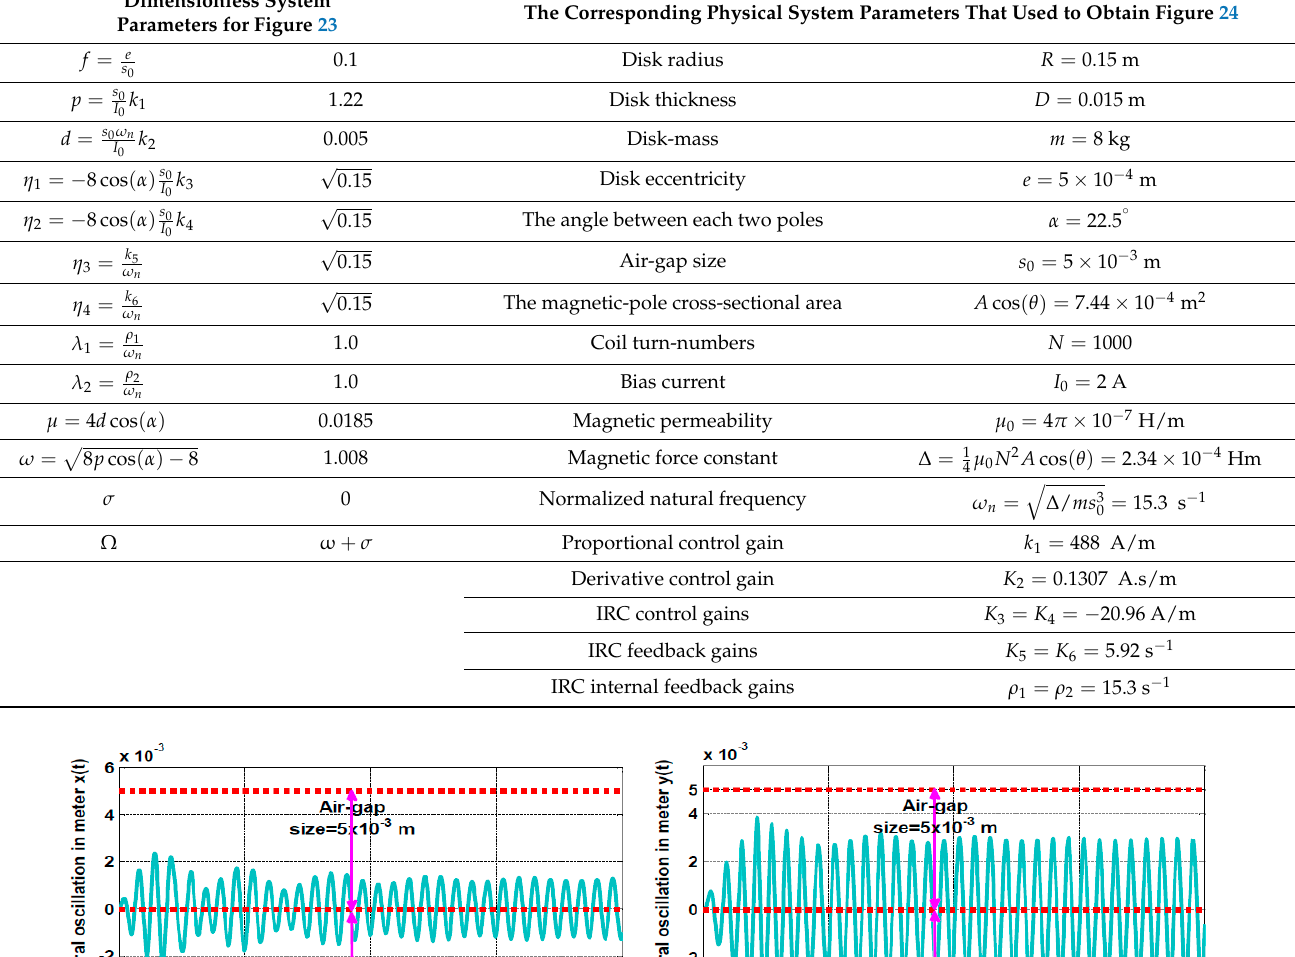
Table 1. Actual system parameters and the corresponding dimensionless parameters.